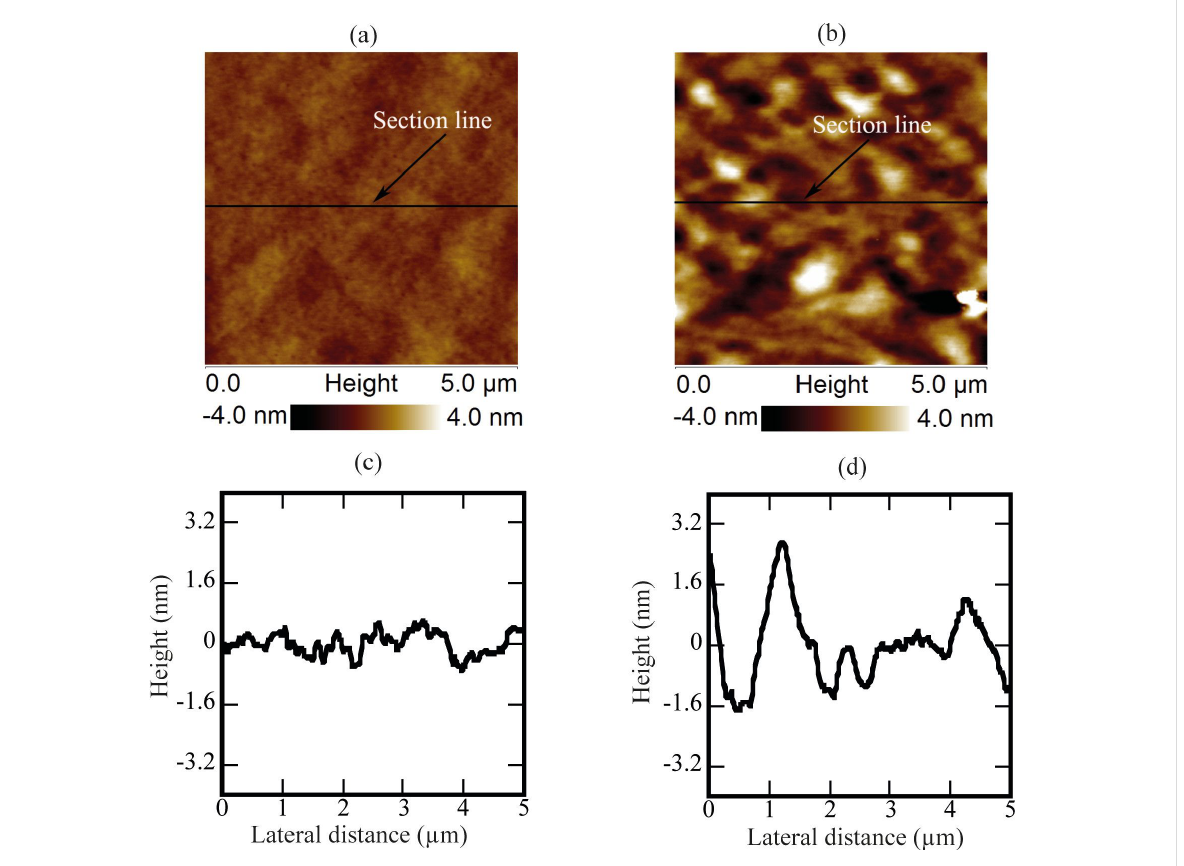
Figure 10: (a,b) AFM images of the PS-coated surface before and after the exposure to water, respectively. (c,d) Height profile analysis of the image of the PS-coated surface before and after the exposure to water. The height profile analysis clearly shows the enhanced features formed on the PS-coated surface. Additional information collected from other surfaces prepared with similar procedures is shown in Supporting Information File 1, Figure S5.